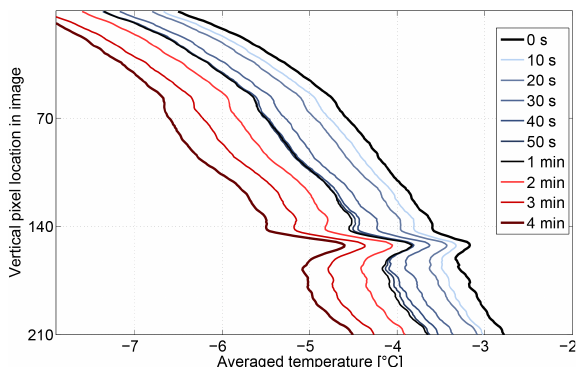
Fig. 2. Thermal picture of a snow pit including a natural crust. Col- orbar in ◦ C.